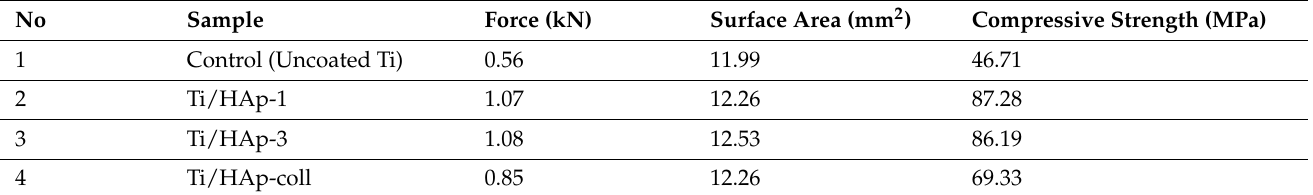
Table 2. Compressive strength of Ti coating with HAp and bovine collagen nanocomposites.